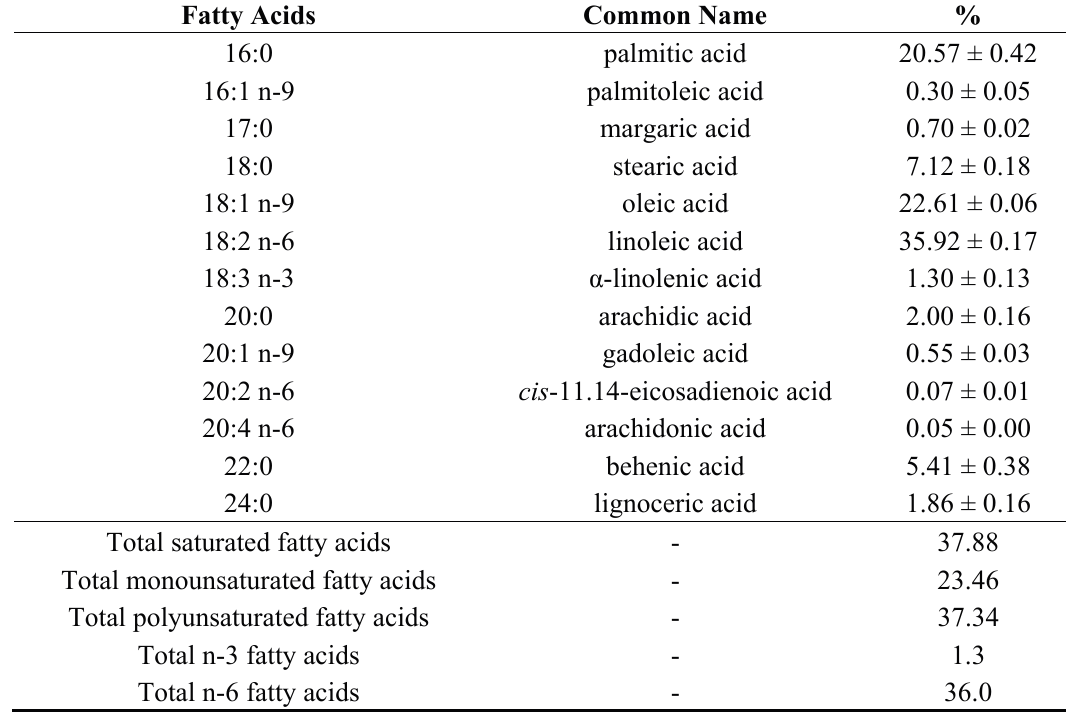
Table 3. Fatty acid composition (%) of lipid extract from Bambara groundnut a